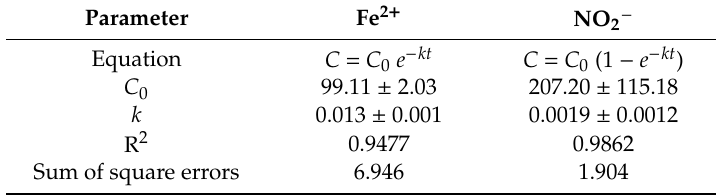
Figure 8. Fe 2 + and NO 2 − concentration produced from NO 3 − reduction. Table 3. First-order model parameters for Fe 2 + removal and NO 2 −